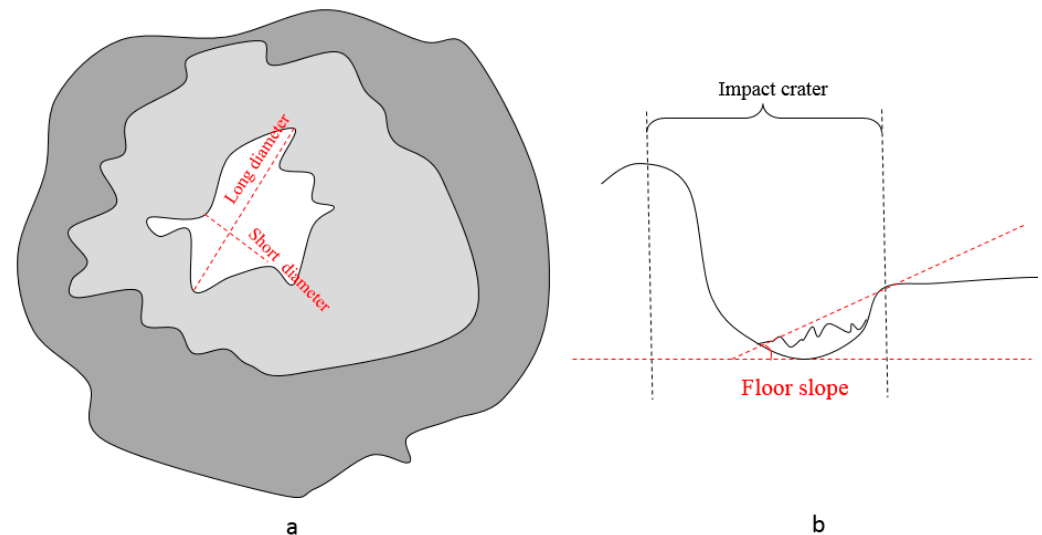
Figure 9. ( a , b ) Schematic description for some of the indices in Table 4. Figure 9. Schematic description for some of the indices in Table 4. Figure 9. Schematic description for some of the indices in Table 4.